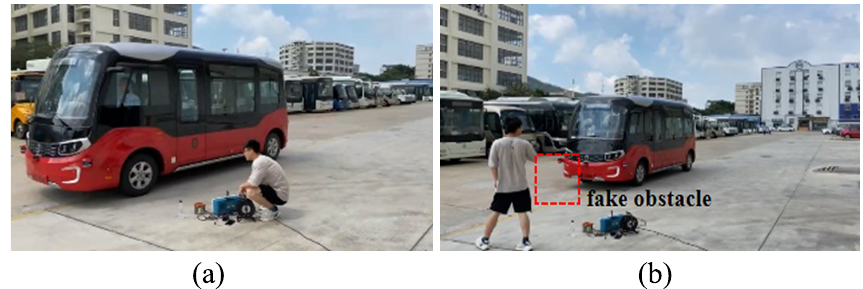
Figure 10. The field test under cyberattack: (a) Working under DHR architecture; (b) Working under one executor